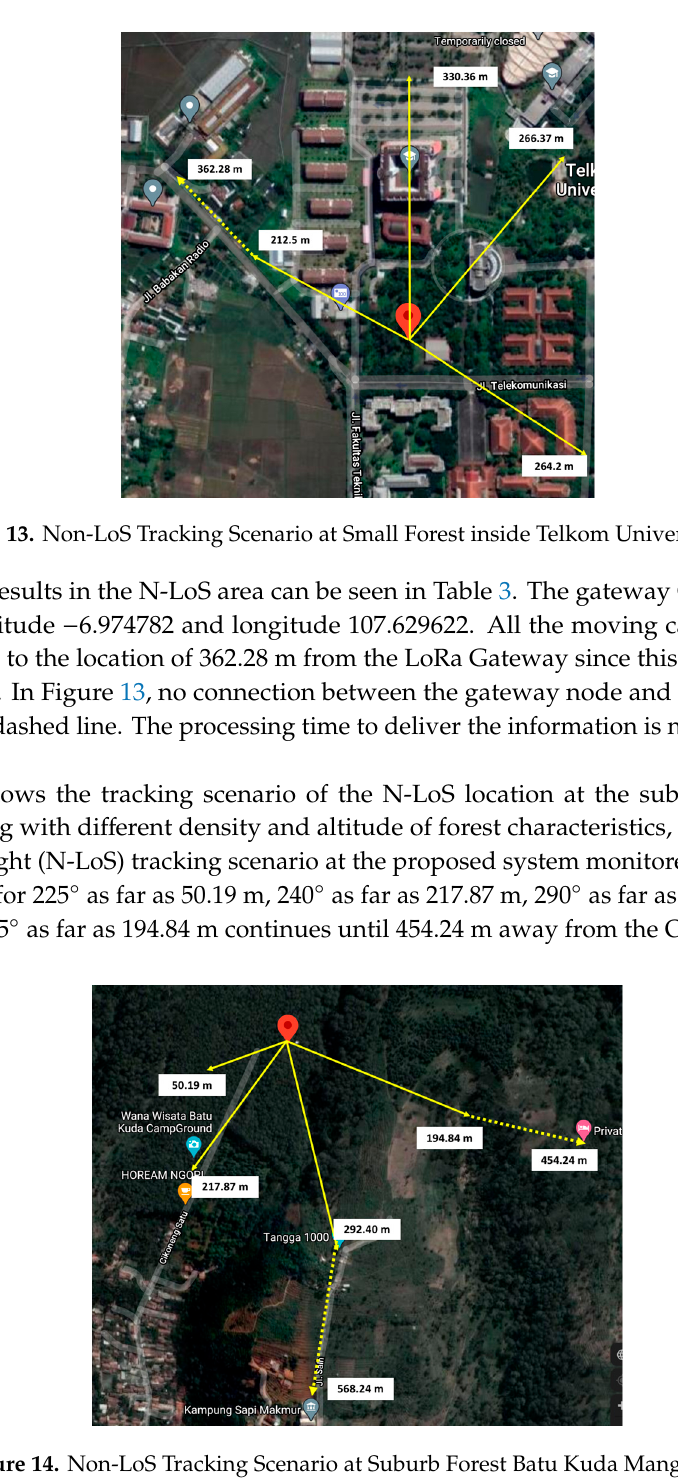
Figure 14. Non - LoS Tracking Scenario at Suburb Forest Batu Kuda Manglayang.